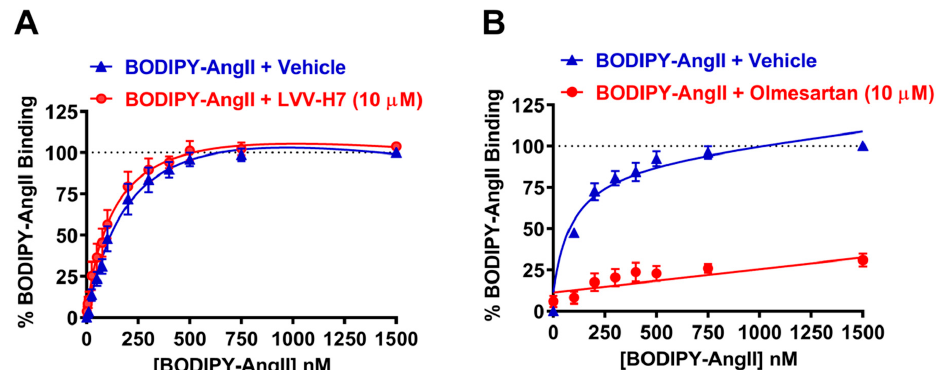
Figure 1. Saturation binding of BODIPY-angiotensin II (AngII) to AngII type 1 receptor (AT1R) using NanoBRET assay in live HEK293FT cells. HEK293FT cells transiently expressing Nluc-AT1R (NanoBRET donor) were first treated with 10 μ M LVV-H7 or vehicle ( A ) or 1 μ M olmesartan medoxomil or vehicle ( B ) for 20 min at 37 °C. Then, cells were incubated with increasing doses of BODIPY-AngII (NanoBRET acceptor) for 40 min at 37 °C before BRET signals were measured. Data are presented as % BODIPY-AngII binding by setting 100% as the maximal NanoBRET signal obtained with BODIPY-AngII in the absence of LVV-H7 ( A ) or olmesartan medoxomil ( B ). Data are mean ± SEM of four ( A ) or three ( B ) independent experiments performed in